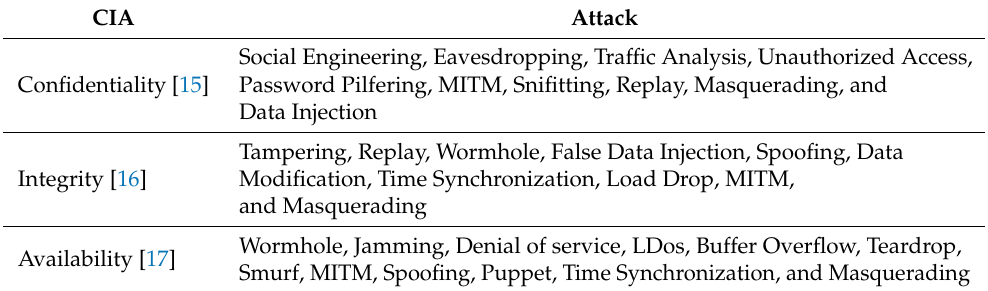
Table 3. CIA classification for smart grid